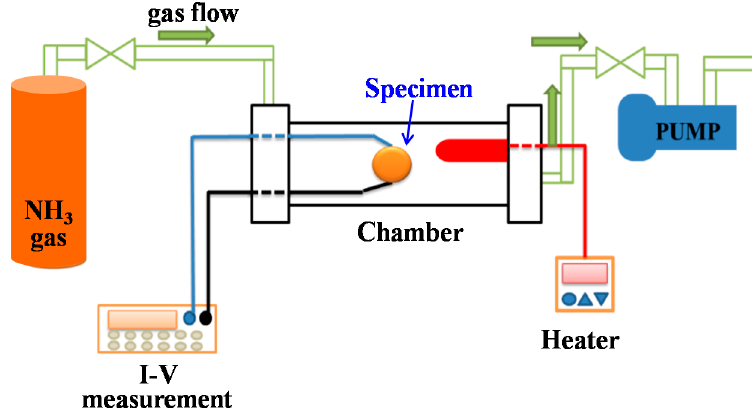
Figure 2. Schematic diagram of the sensing device.